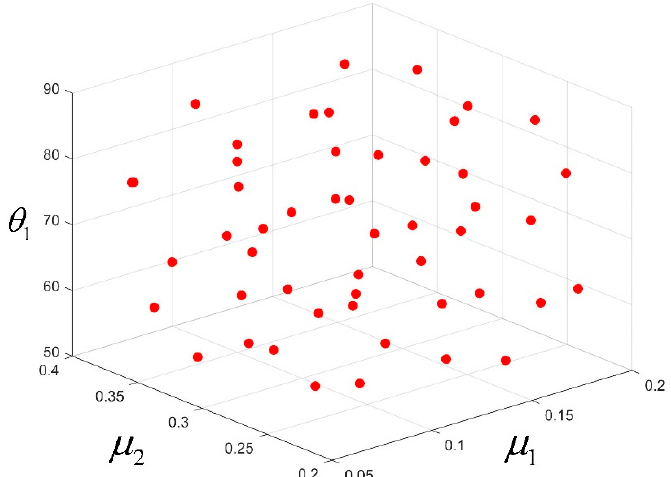
Figure 16. Random and optimal Latin hypercube-sampling trial-point distributions: ( a ) random Latin hypercube sampling, ( b ) optimal Latin hypercube sampling.